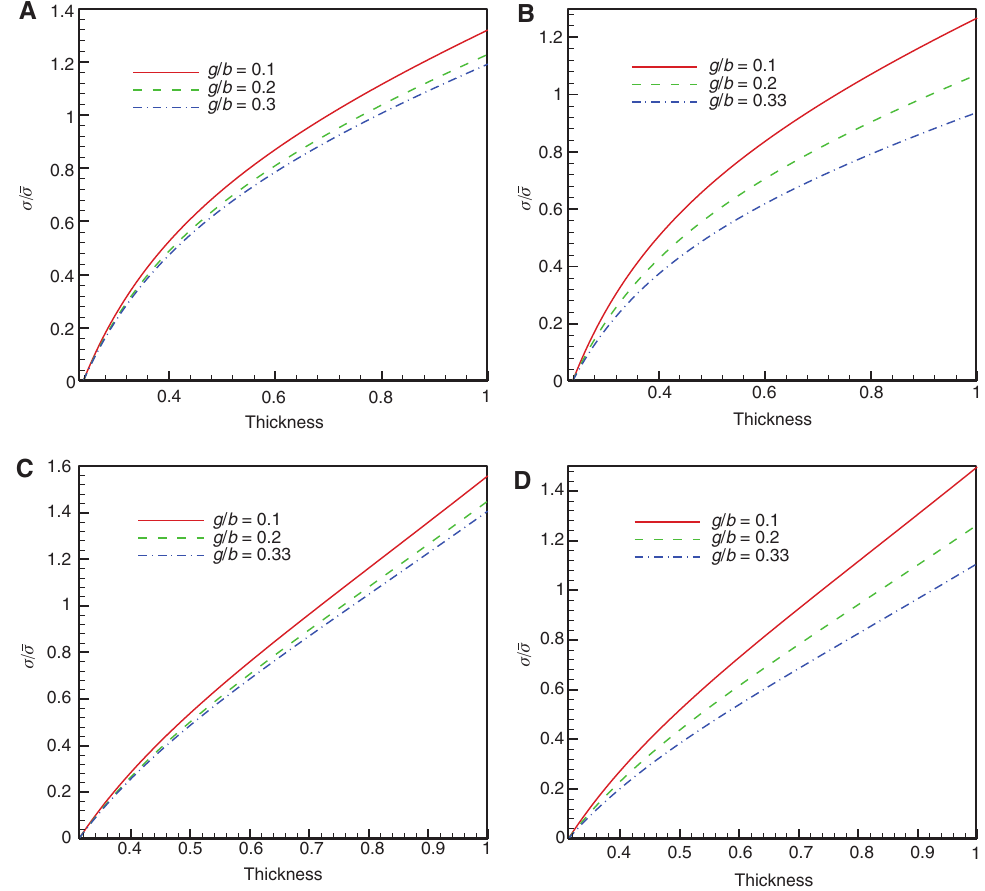
Figure 4: Variation of non-dimensional stress through the thickness for SCSC and SFSC micro-plate. (A) SCSC micro-plate ( n = 1), (B) SFSC micro-plate ( n = 1), (C) SCSC micro-plate ( n = 2), and (D) SFSC micro-plate ( n =